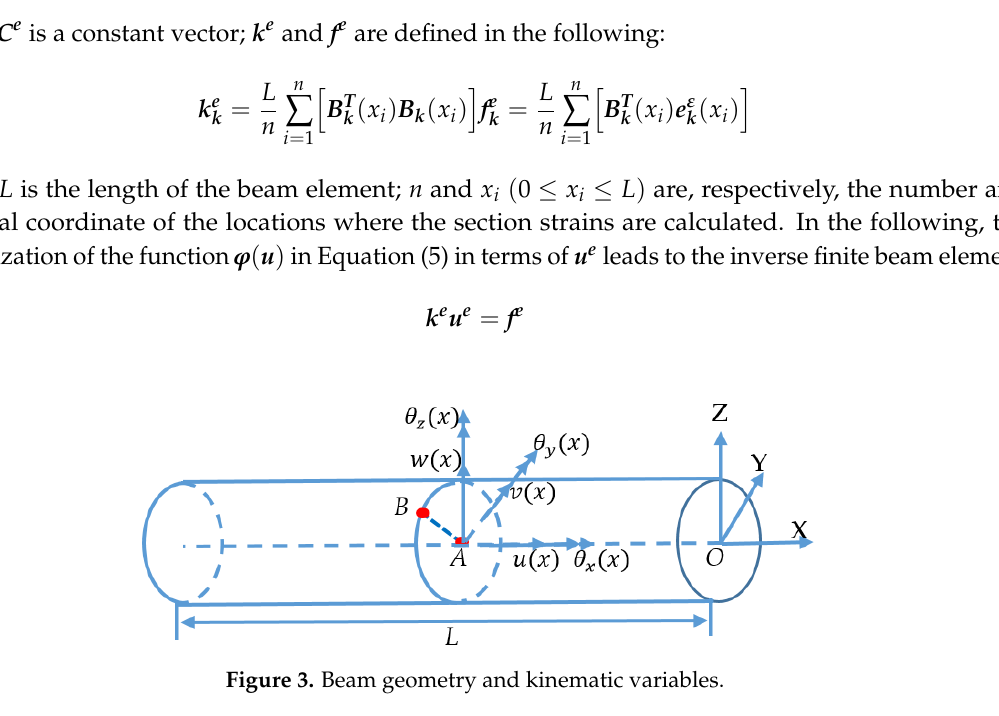
Figure 2. The simple physical model of the radio telescope and its size: ( a ) Telescope model; ( b ) The size of the whole structure ; ( c ) The size of the fixed platform; ( d ) The size of the main reflector; ( e ) The size of the pedestal; ( f ) The size of the iron plate.